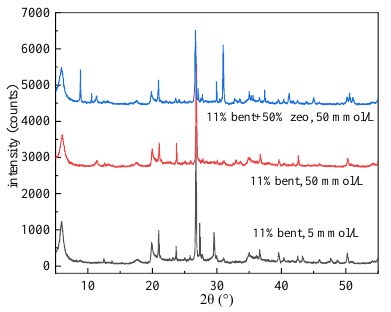
Figure 10. Change of XRD.